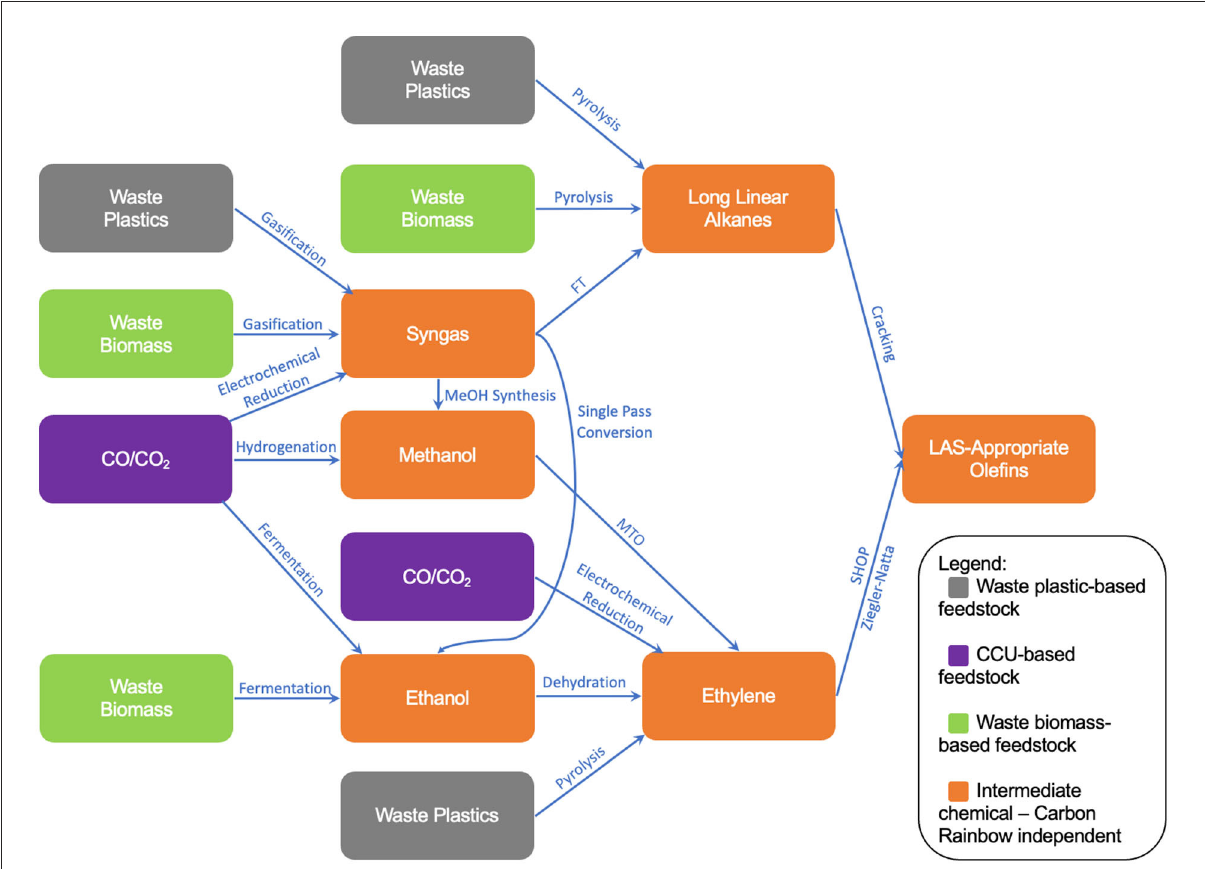
FIGURE11 Finalized formulation tree diagram showing the new routes to LAS-appropriate olefins within the scope of this